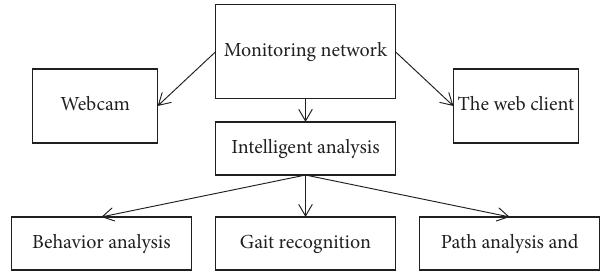
Figure 2: Dense trajectory of traditional feature extraction